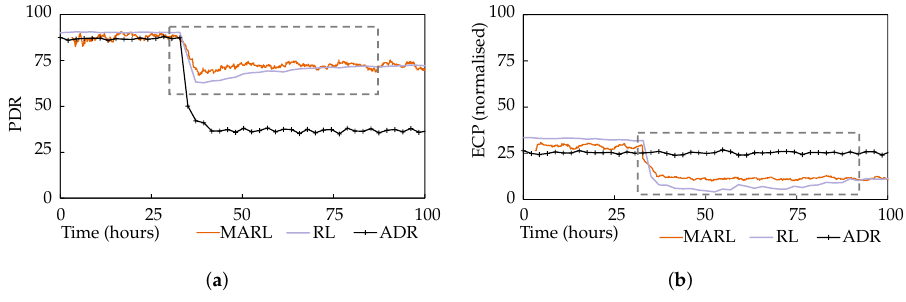
Figure 8. Scenario 2 results: ( a ) PDR performance for scenario 2. ( b ) ECP performance for scenario